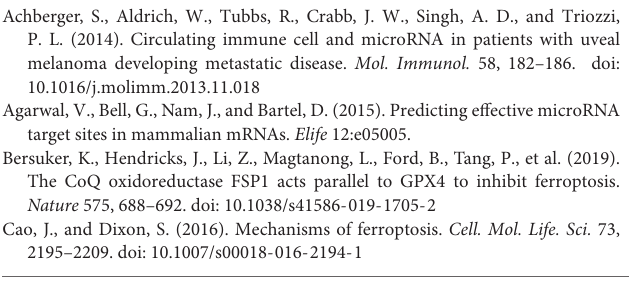
(B) Consensus clustering cumulative distribution function (CDF) and relative change in area under CDF curve for k = 2 in module B. (C) Kaplan–Meier curves of two clusters in UVM about OS in module B. (D) Different expression of the ferroptosis-related mediators in two clusters based on module B (*** p < 0.001; ** p < 0.01; * p < 0.05). Supplementary Figure 2 | Tumor immune microenvironment in module B. (A) Different expression of ESTIMATE score in two clusters. (B) Different distribution of 22 TME infiltrating cells in two patterns (*** p < 0.001; ** p < 0.01; * p < 0.05). Supplementary Figure 3 | Prognostic analysis of risk model and ferroptosis-related genes in module B. (A) Kaplan–Meier curves of patients in high/low risk about OS in module B. (B) Distributions of risk scores, alive/dead status, and expression of ferroptosis-related genes in module B. (C) ROC curve of risk score and clinical characteristics in module B. (D) Kaplan–Meier curves of patients in high/low risk about OS based on GSE84976. Supplementary Figure 4 | Prognostic value of ferroptosis-related genes. (A) Kaplan–Meier DSS curves of patients in key ferroptosis-related genes. (B) Kaplan–Meier PFI curves of patients in key ferroptosis-related genes. Supplementary Figure 5 | Evaluation of key ferroptosis-related genes in immune cell infiltration. (A) Relationship between ABCC1, CHAC1, and GSS expression and infiltrating immune cells. (B) Relationship between key genes expression and level of CD274 and CD279. Supplementary Figure 6 | Correlation of key ferroptosis-related genes and mRNAs with positive polymorphisms. (A) Correlation of ABCC1 and mRNAs with positive polymorphisms. (B) Correlation of CHAC1 and mRNAs with positive polymorphisms. (C) Correlation of GSS and mRNAs with positive polymorphisms. Supplementary Table 1 | Sixty ferroptosis-related genes list.